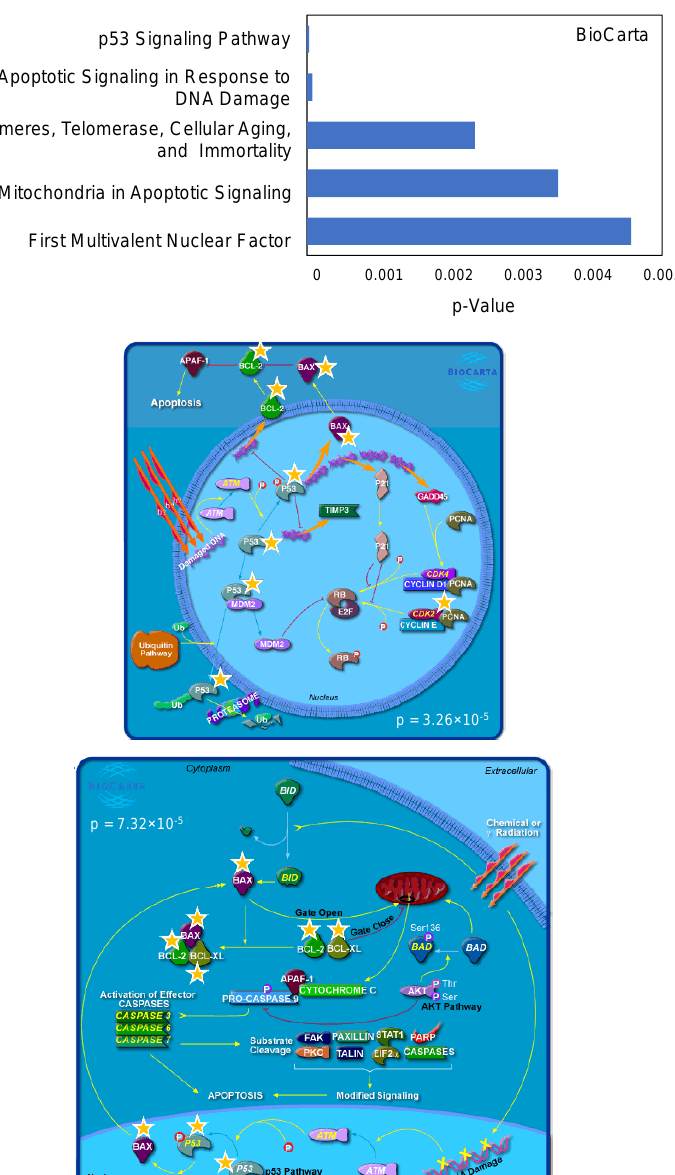
Figure 4. Top-ranked pathways associated with BTZ resistance in MCL cells. ( A ) Lists of top-ranked BioCarta pathways generated from lists of significantly changed genes between parental Z/Parent and BTZ-resistant Z/500R cells. ( B ) Schematic diagrams of the p53 signaling pathway ( upper ) and the apoptosis signaling in response to DNA damage ( lower ) generated by BioCarta. Yellow stars indicate listed genes.